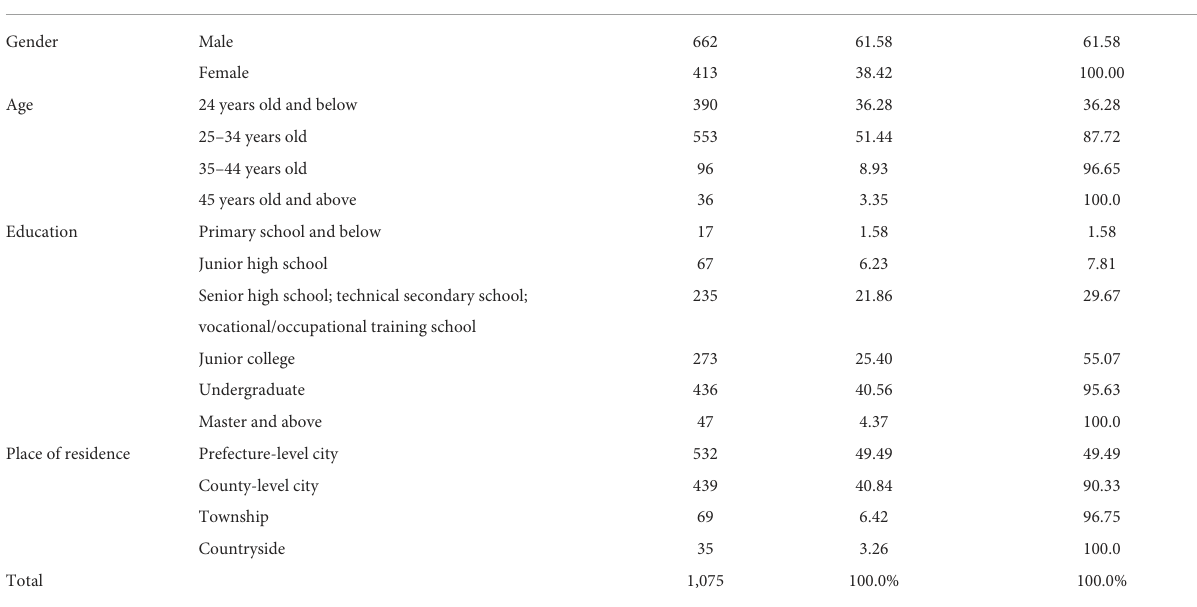
TABLE 1 Descriptive statistical analysis of sample structure ( N =